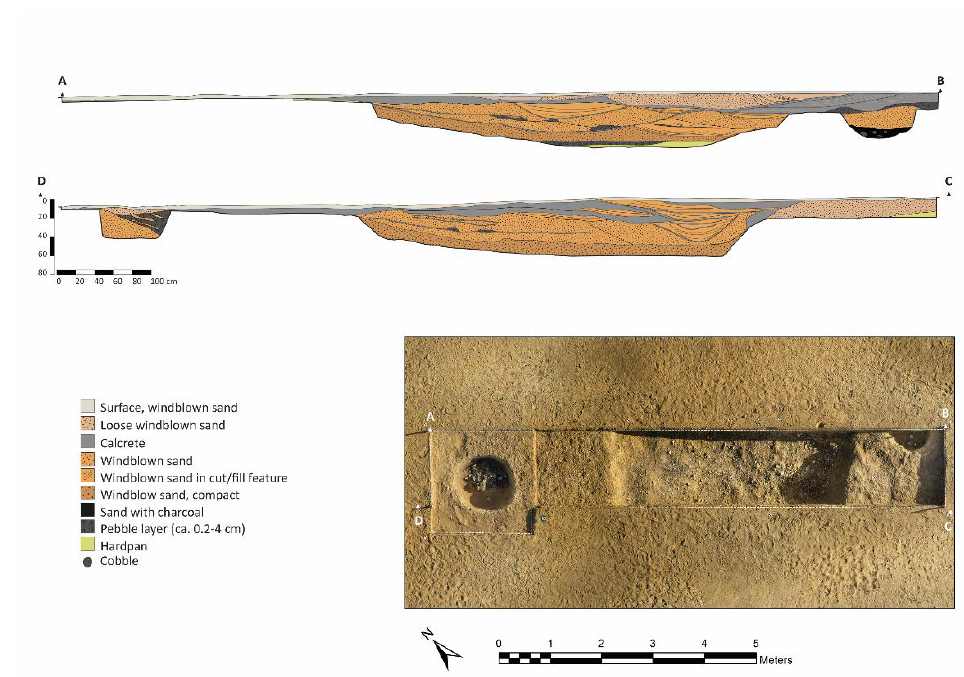
Figure 10 . Illustrated profile and plan view photo of trench dug perpendicular to channel with adjacent pit. Base of channel approximately 4–5 m wide in center of trench (deepest part).